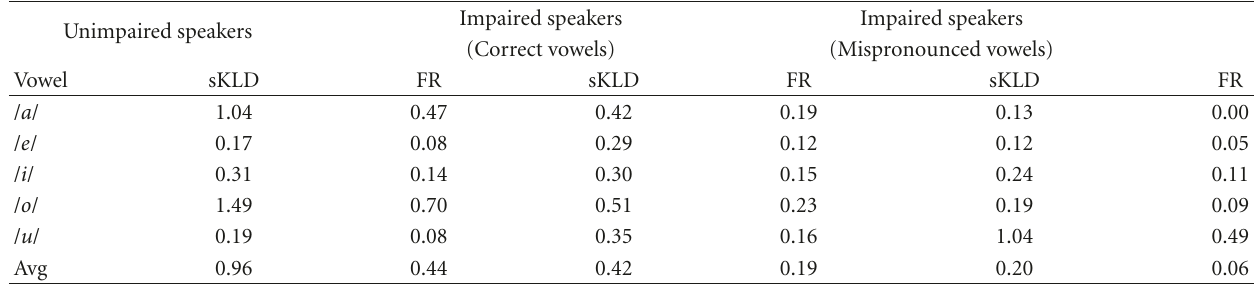
Table 15: sKLD and FR in energy between stressed and unstressed vowels (Avg is the weighted average over the number of appearances of every